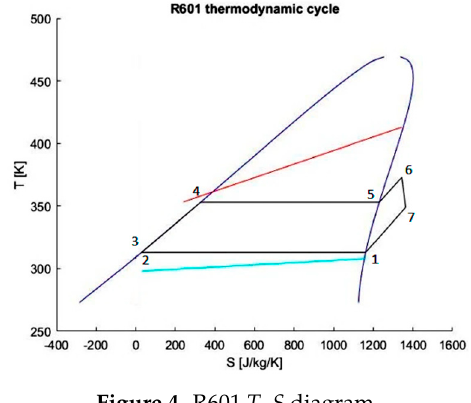
Figure 4. R601 T – S diagram. Table 2. R601 thermodynamic parameters.